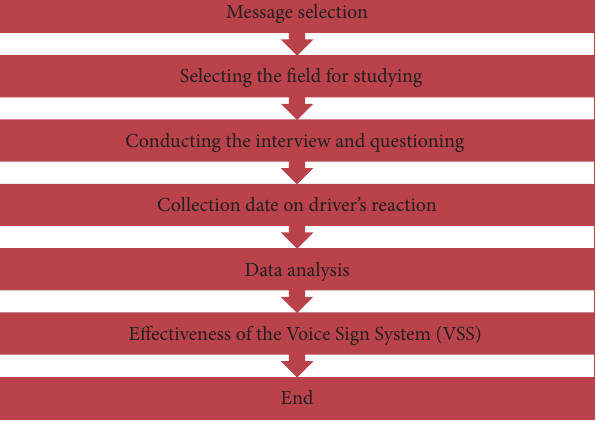
Figure 1: Research procedure.